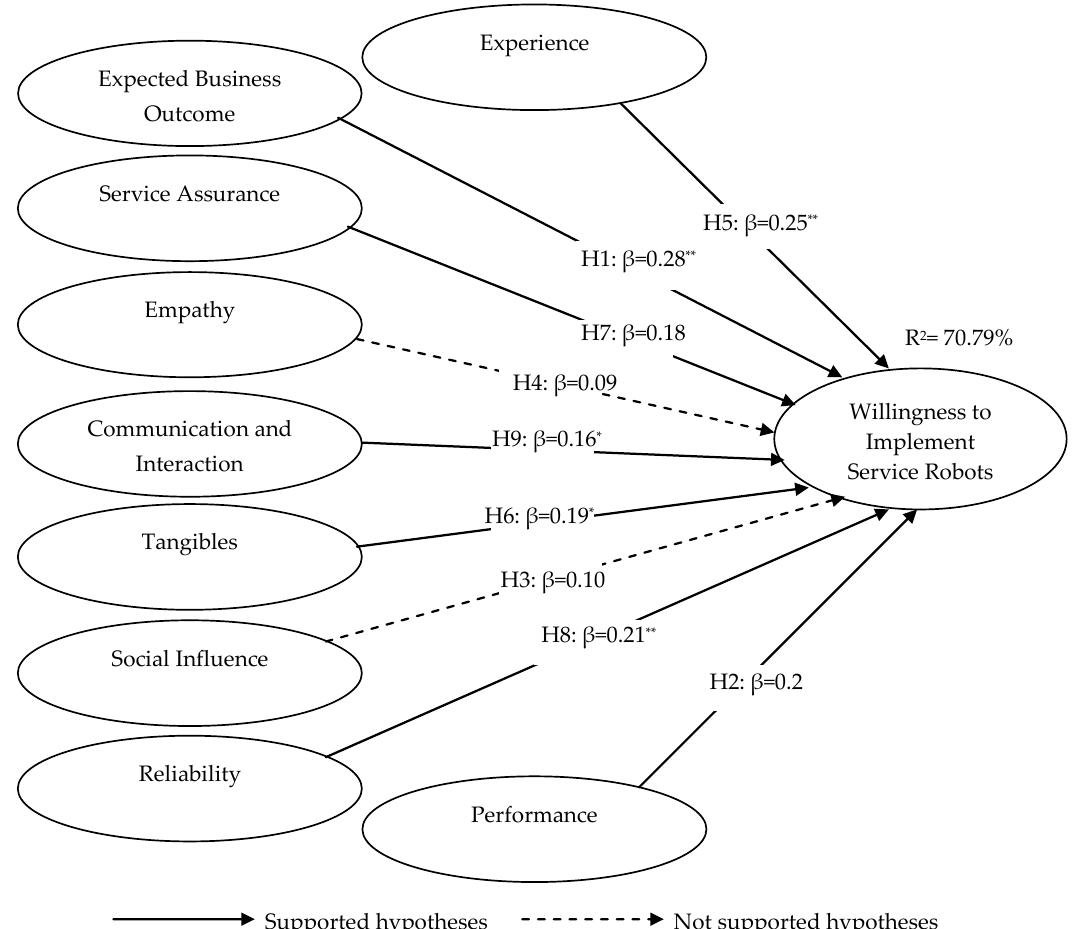
Figure 1. Proposed conceptual model. * p < 0.05; and ** p <